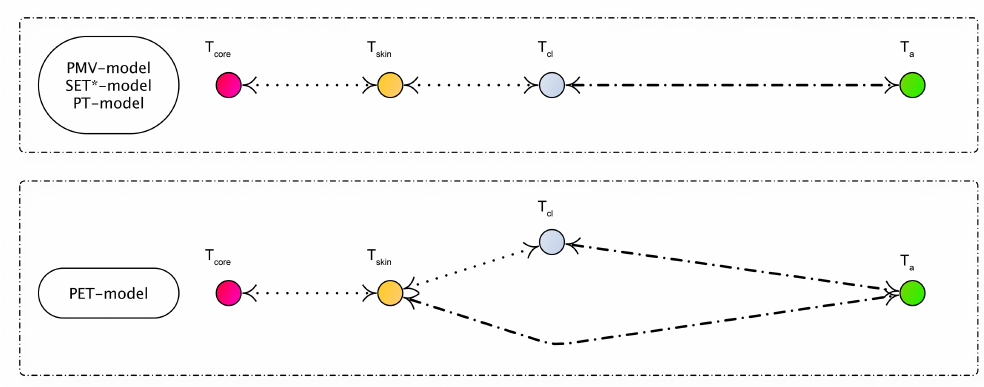
Figure 2. Comparison of sensible heat transfer between computational models of PMV, SET*, PT, and PET. Table 1. Comparison between PET, SET* and UTCI. PET